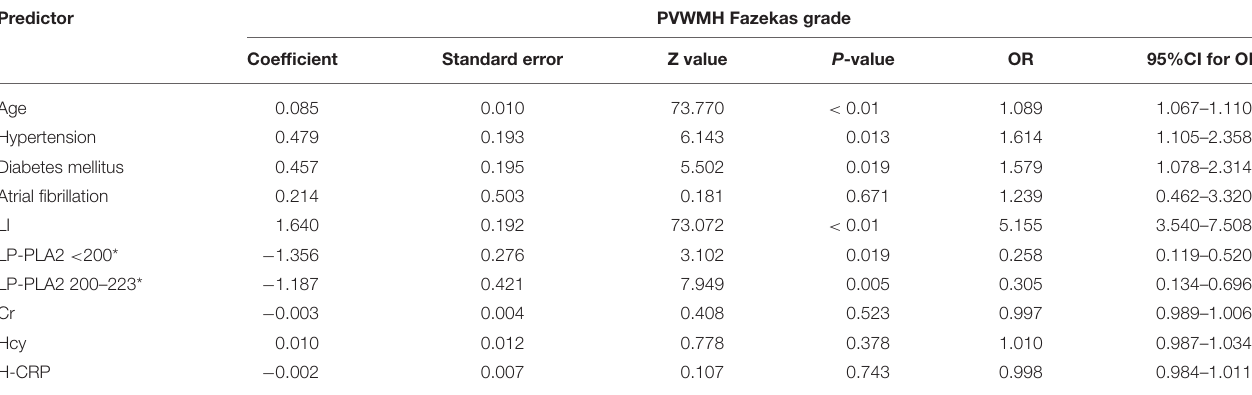
TABLE 4 | Ordinal regression model analysis of influencing factors of PVWMH